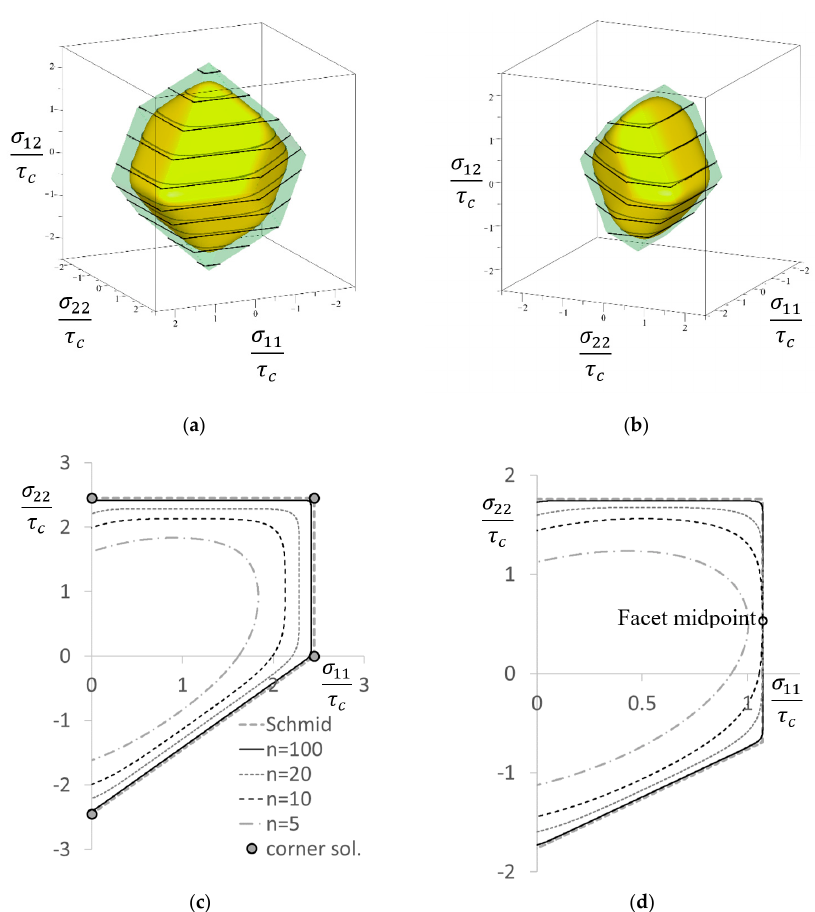
Figure 8. Sections of the fcc (cid:4668)1(cid:4636)10(cid:4669)⟨111⟩ crystal yield surface. ( a ) The 𝜎 (cid:2869)(cid:2869) - 𝜎 (cid:2870)(cid:2870) - 𝜎 (cid:2869)(cid:2870) section with 𝜎 (cid:2869)(cid:2871) = 𝜎 (cid:2870)(cid:2871) = 0 . ( b ) The 𝜎 (cid:2869)(cid:2869) - 𝜎 (cid:2870)(cid:2870) - 𝜎 (cid:2869)(cid:2870) section with 𝜎 (cid:2870)(cid:2871) = −0.689𝜏 (cid:3030) and 𝜎 (cid:2869)(cid:2871) = 0 . ( c ) The 𝜎 (cid:2869)(cid:2869) - 𝜎 (cid:2870)(cid:2870) shear-stress-free section with 𝜎 (cid:2871)(cid:2871) = 𝜎 (cid:2869)(cid:2870) = 𝜎 (cid:2869)(cid:2871) = 𝜎 (cid:2870)(cid:2871) = 0 . The corner solutions are indicated in this section. ( d ) The section 𝜎 (cid:2869)(cid:2869) - 𝜎 (cid:2870)(cid:2870) with 𝜎 (cid:2869)(cid:2870) = −𝜎 (cid:2870)(cid:2871) = 0.689𝜏 (cid:3030) and 𝜎 (cid:2869)(cid:2871) = 0 . The facet midpoint in this section is indicated. The critical resolved shear stress 𝜏 (cid:3030) is equal for all slip systems and 𝜉 (cid:3046) ≡ 1 . In ( a , b ), the Schmid surface is compared to 𝑛 = 10 . In ( c , d ), the indicated yield surface exponents 𝑛 are compared to the Schmid solution.